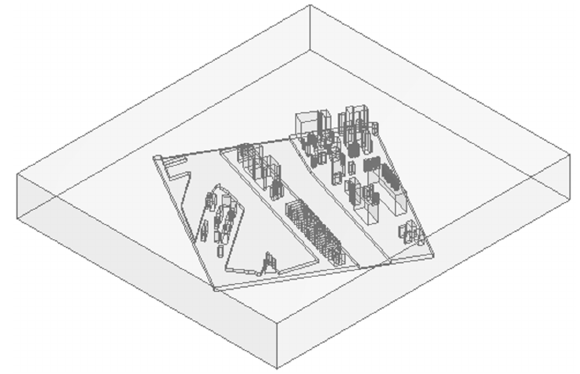
Figure 12. The function of rotating the CAD model.